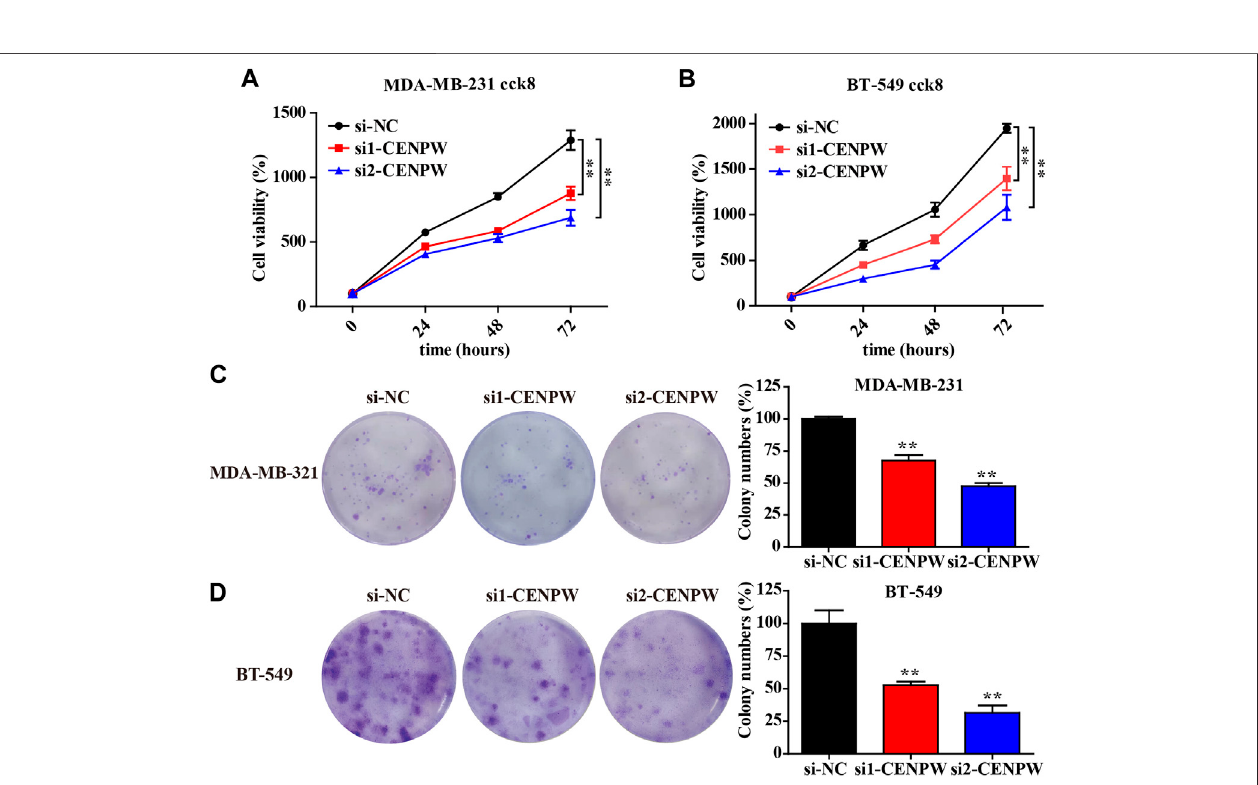
FIGURE 9 | Knockdown of CENPW inhibits breast cancer cell proliferation. (A,B) Cell proliferation capability of control and CENPW knockdown cells. (C,D) The colony formation of breast cancer cells with or without CENPW knockdown. Quantitative histograms of colony formation are shown on the right. * p < 0.05, ** p < 0.01 compared with si-NC